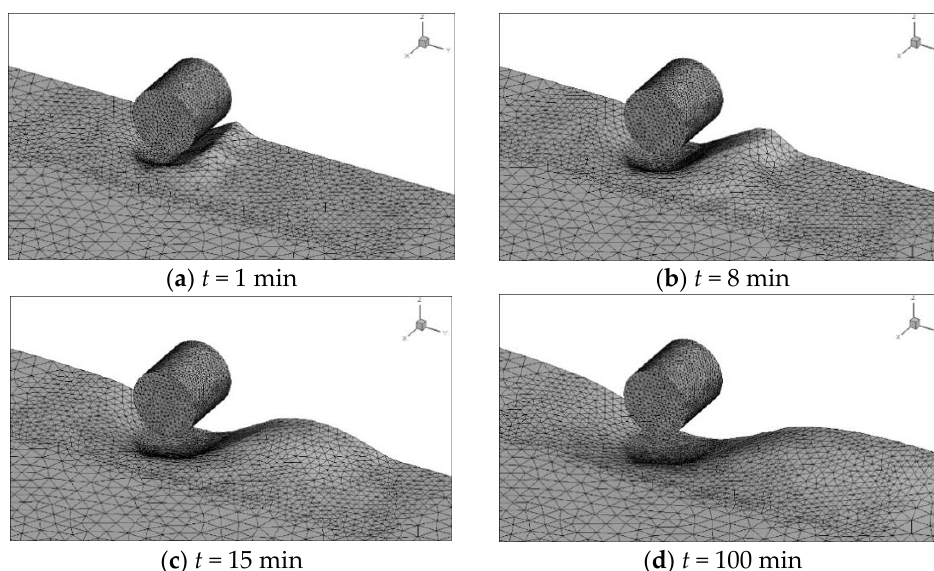
Figure 10. Development of the bed shape for L = 2 D.